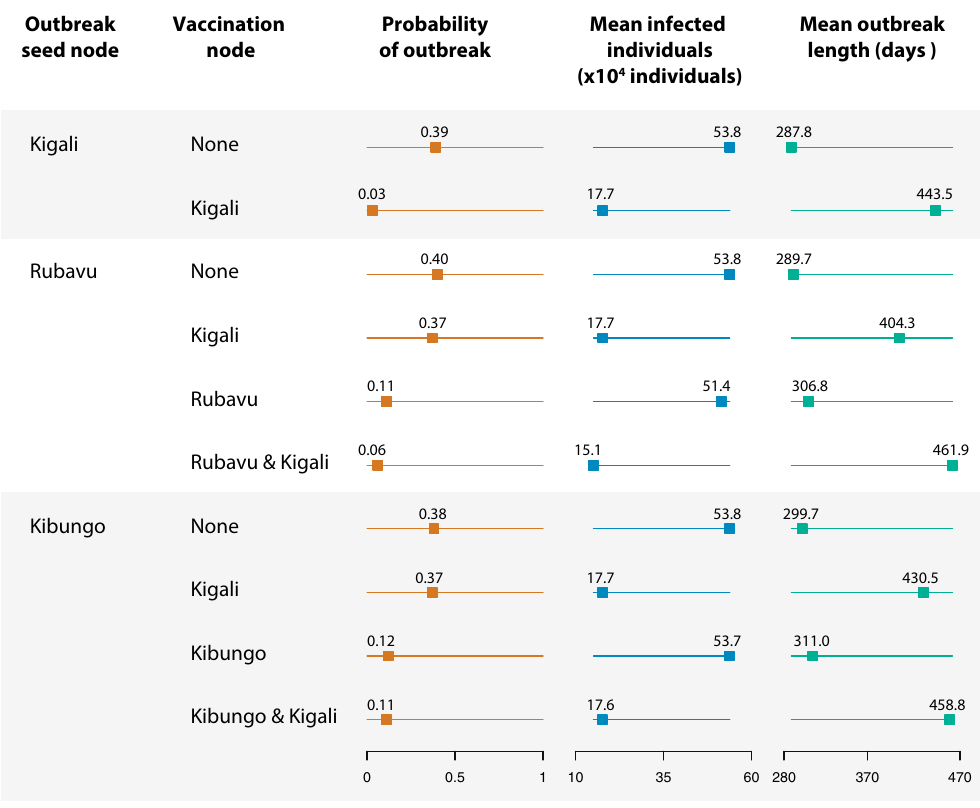
Figure 8. Comparison of the numbers infected and the outbreak lengths for scenarios involving different sites for the start of a potential epidemic and places of vaccinations (60% population coverage with an 80% efficacious vaccine). Outbreak probabilities and numbers of infected individuals were lowest when both Kigali and Rubavu/ Kibungo (other cities where outbreaks were initiated) were